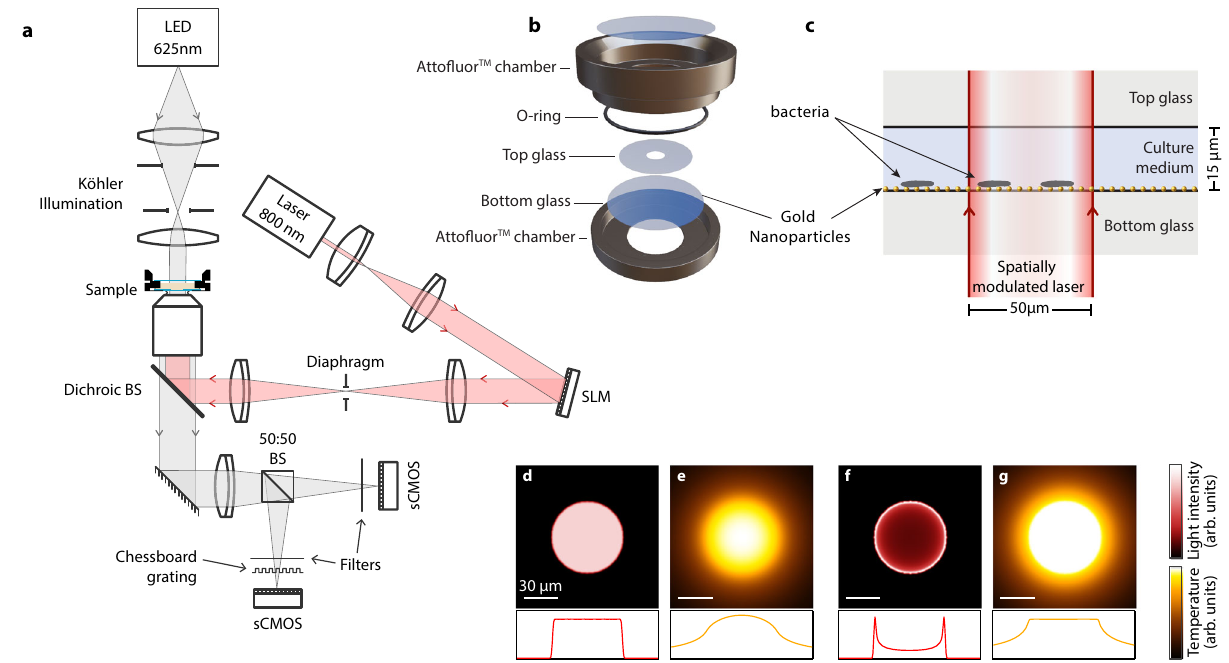
Fig.1|Experimentalapproach.a Schematicofthesetupforparallellaserheating, shaping and temperature microscopy. b Sample geometry, consisting of an Atto- fl uor TM chamber containing a coverslip covered with gold nanoparticles. c Close look at the sample (not to scale). d Representation of a uniform laser beam pro fi le